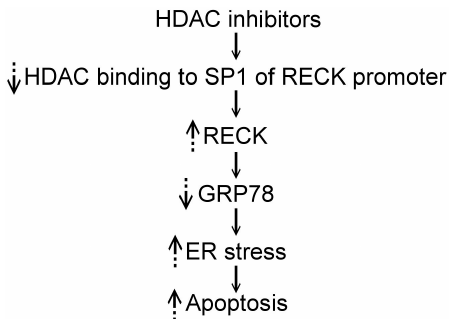
Figure 1. The pathway of the influence of HDAC inhibitors on the ER stress in the tumor cells is speculated as: HDAC inhibitors prevent the binding of HDAC to the SP1 site of the RECK promoter and then increase RECK expression; the increased RECK sequesters GRP78 and eventually activates ER stress and causes cellular apoptosis. ↓ indicates pathway. ↑ indicates increased. ↓ indicates